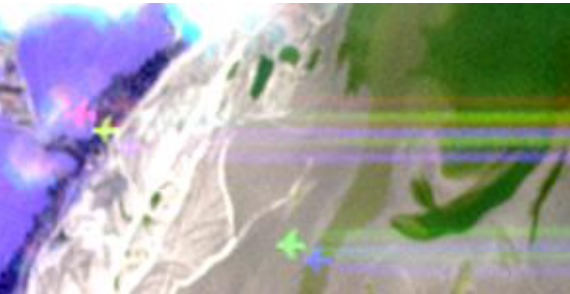
Figure 11: Detailled view of a plane in a RapidEye image, section 1500 × 750 m, all five channels (left to right): red, red-edge (as yellow), NIR (as purple), green, blue Table 4: Relative distances of bands in RapidEye FPA from plane distance measurements Bands